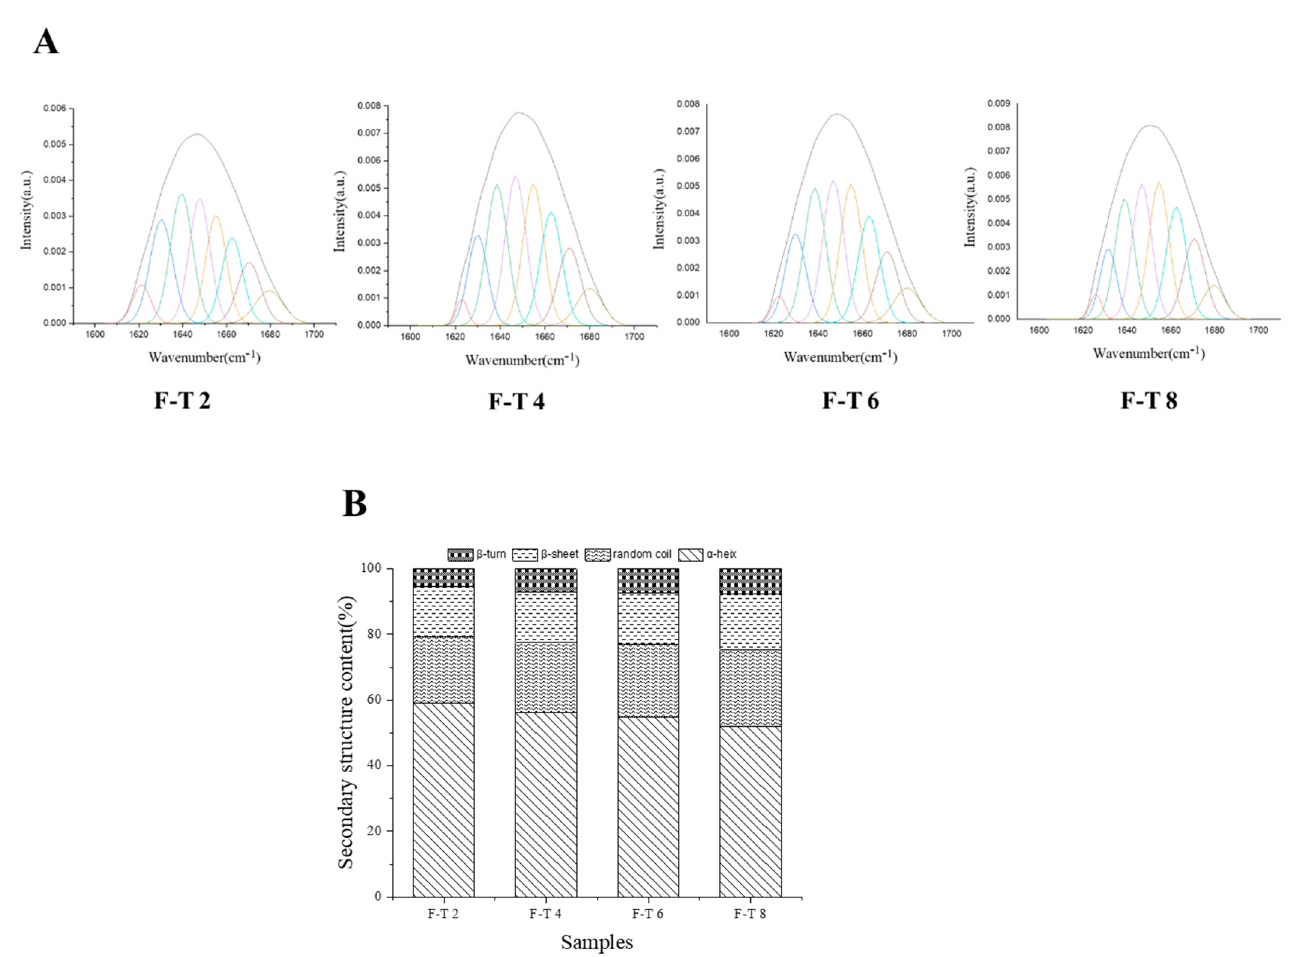
Figure 2. The iterative curve-fitted ( A ) and the proportions ( B ) of the second structure of the sample in varying freeze – thaw (F – T) cycles by FT-IR spectra.